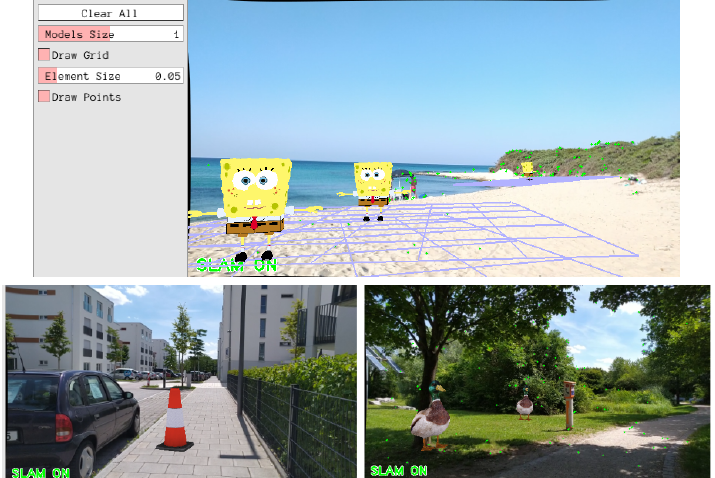
Figure 6. The augmented 3D models change based on the surroundings, thanks to the semantic knowledge present in the reconstructed 3D map. If an object is placed on sand, a cartoon character appears, on the pavement a pylon is visible and on grass a duck can be placed. The user has different options: change the model and the plane size, clear all the drawn models, hide the planes, and show the tracked keypoints (green